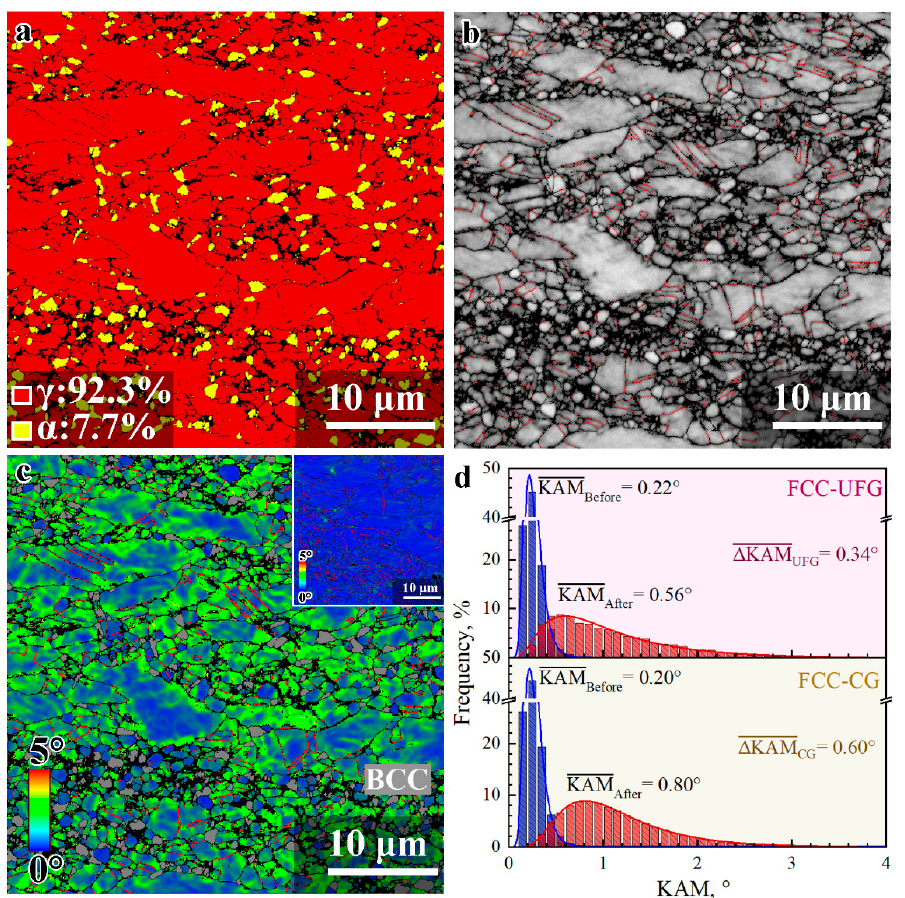
Figure 7. The microstructure characterization by EBSD for the CR sample after tensile testing. ( a ) KAM mapping. ( b ) Histogram distributions of KAM value.